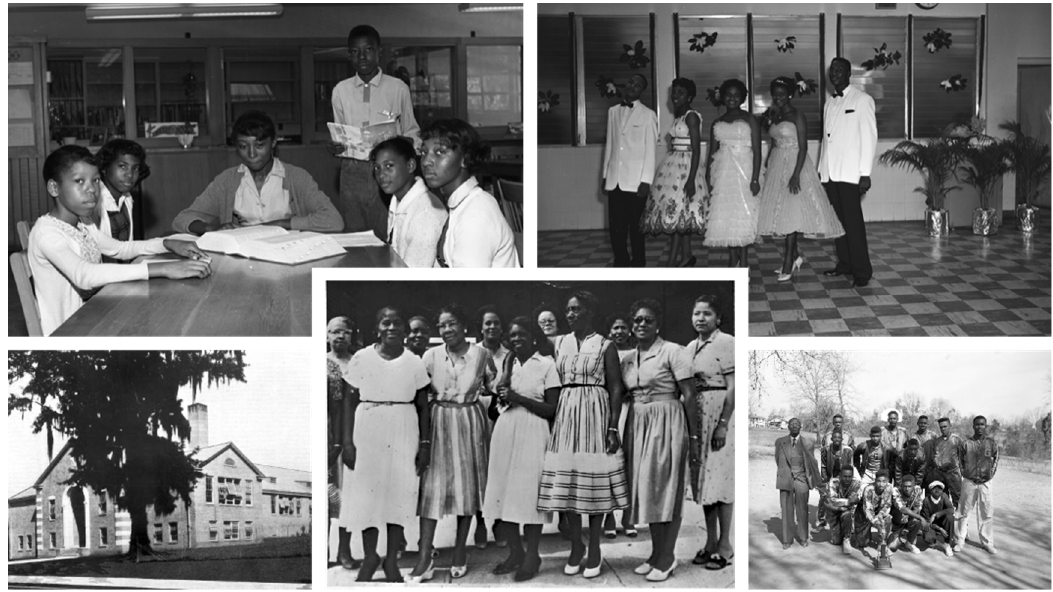
Figure 2. Historical photographs of teachers and students at Lincoln High School (Source: Riley Archives).